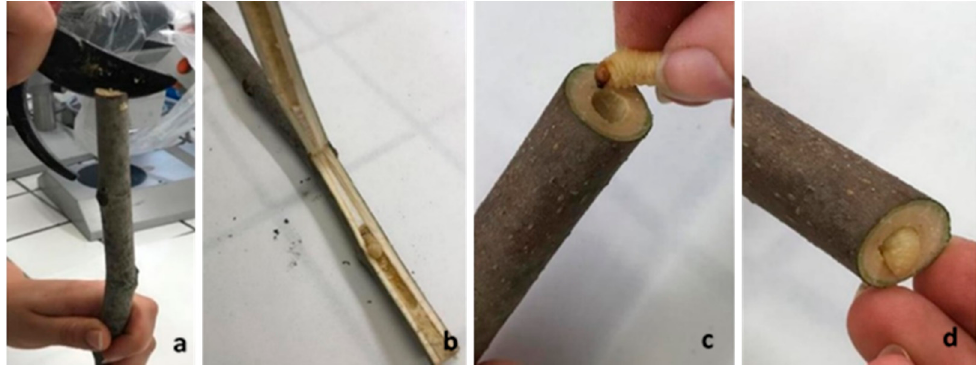
Figure 2. Aclees taiwanensis larval rearing: ( a ) fig branch cut obliquely, ( b ) larval gallery, and ( c , d ) larva entering in the